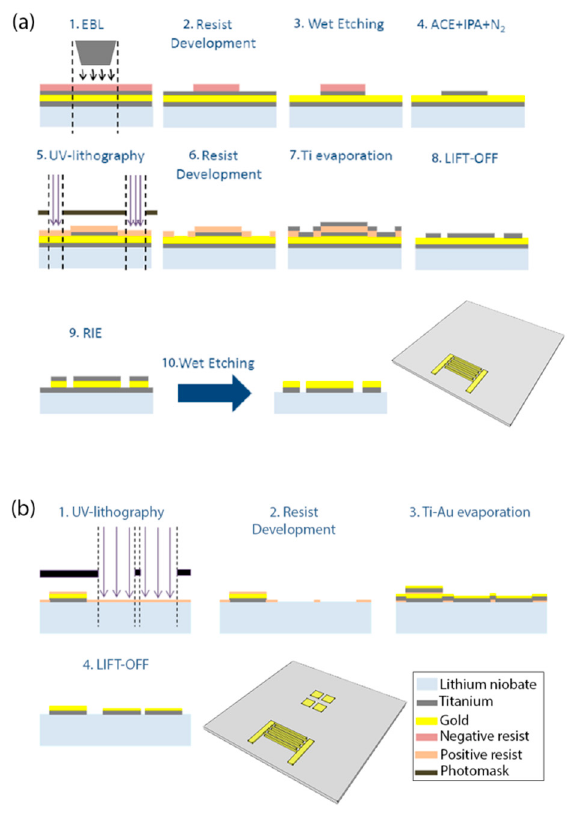
Figure 2. Fabrication process for the ( a ) IDT and ( b ) SPR sensing areas. ( a ) The first step is the